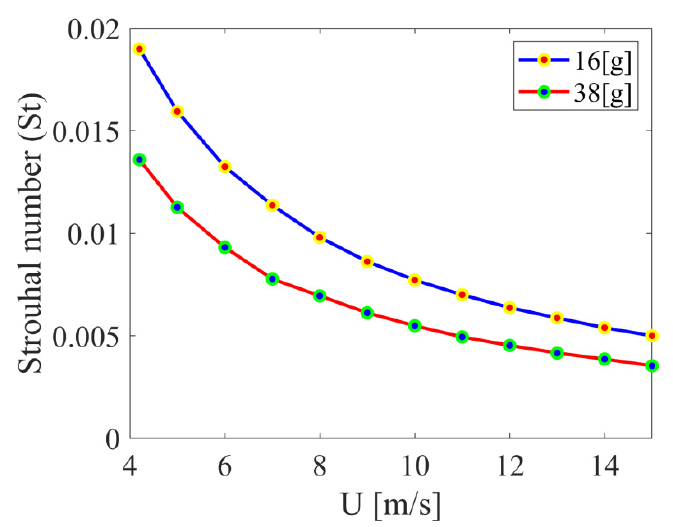
Figure 8. Strouhal number St as a function of air flow velocity for the two bluff body masses for the case without external excitation. The natural frequency of the vibrating bluff body was used in Eq. 1 as the specific frequency f .